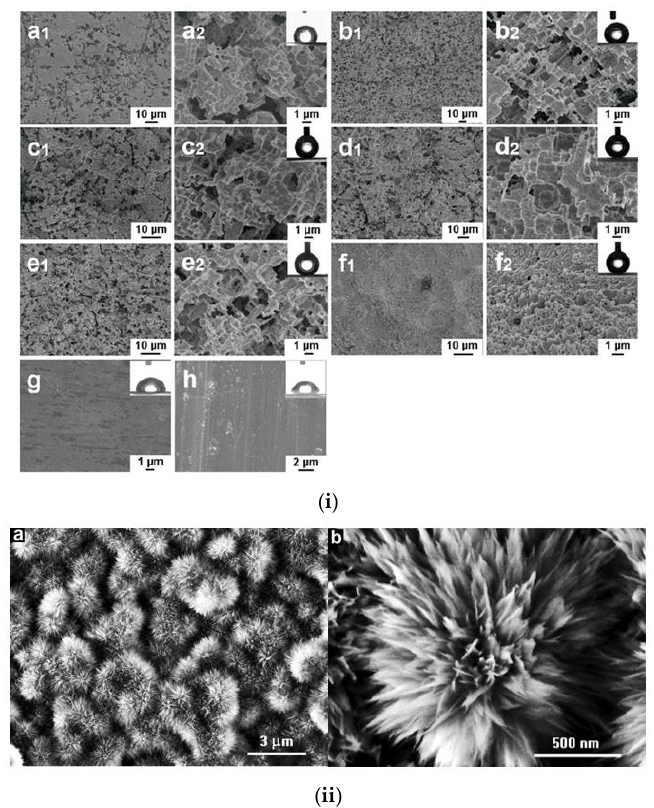
Figure 4. ( i ) SEM images of Al after immersion in HCl for ( a1 , a2 ) 15 min, ( b 1 , b 2 ) 30 min, ( c 1 , c 2 ) 60 min, ( d 1 , d 2 )75 min, and ( e 1 , e 2 ) 90 min respectively. ( f 1 , f 2 ) SEM images of Zn after immersion for 75 min. ( g , h ) The bare Al and Zn surfaces before etching. Reproduced with permission from [53]. ( ii ) SEM images of the resulting boehmite film on the aluminum foil prepared after immersing in a heated aqueous solution of aluminum chloride (AlCl 3 ) and triethanolamine (TEA). Reproduced with permission from